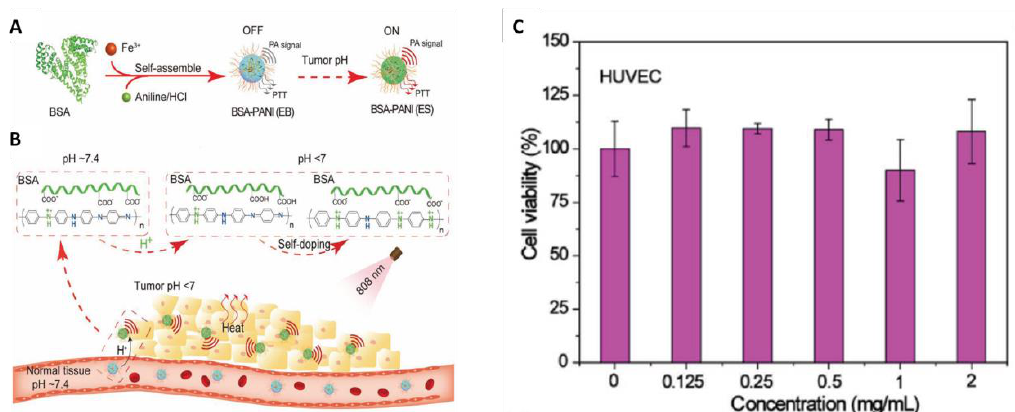
Figure 4. ( A ) Schematic illustration for the preparation bovine serum albumin (BSA)-polyaniline (PANI) assemblies. ( B ) BSA-PANI assemblies for amplified photoacoustic imaging and augmented photothermal therapy. The potential mechanism is based on intermolecular acid–base reactions between carboxyl groups of BSA and imine moieties of PANI. ( C ) In vitro biocompatibility of the BSA-PANI assemblies for noncancerous HUVECs cells after 24 h of incubation. (images are reproduced from [31] with the copyright permission from WILEY-VCH Verlag GmbH &